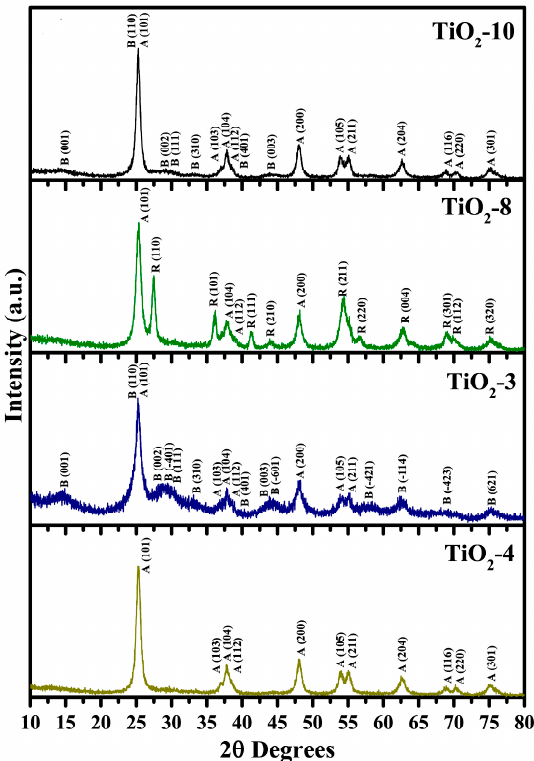
Figure 1. Powder X-ray diffraction of hard templated mesoporous TiO 2 as function of impregnation cycles and titanium precursor.